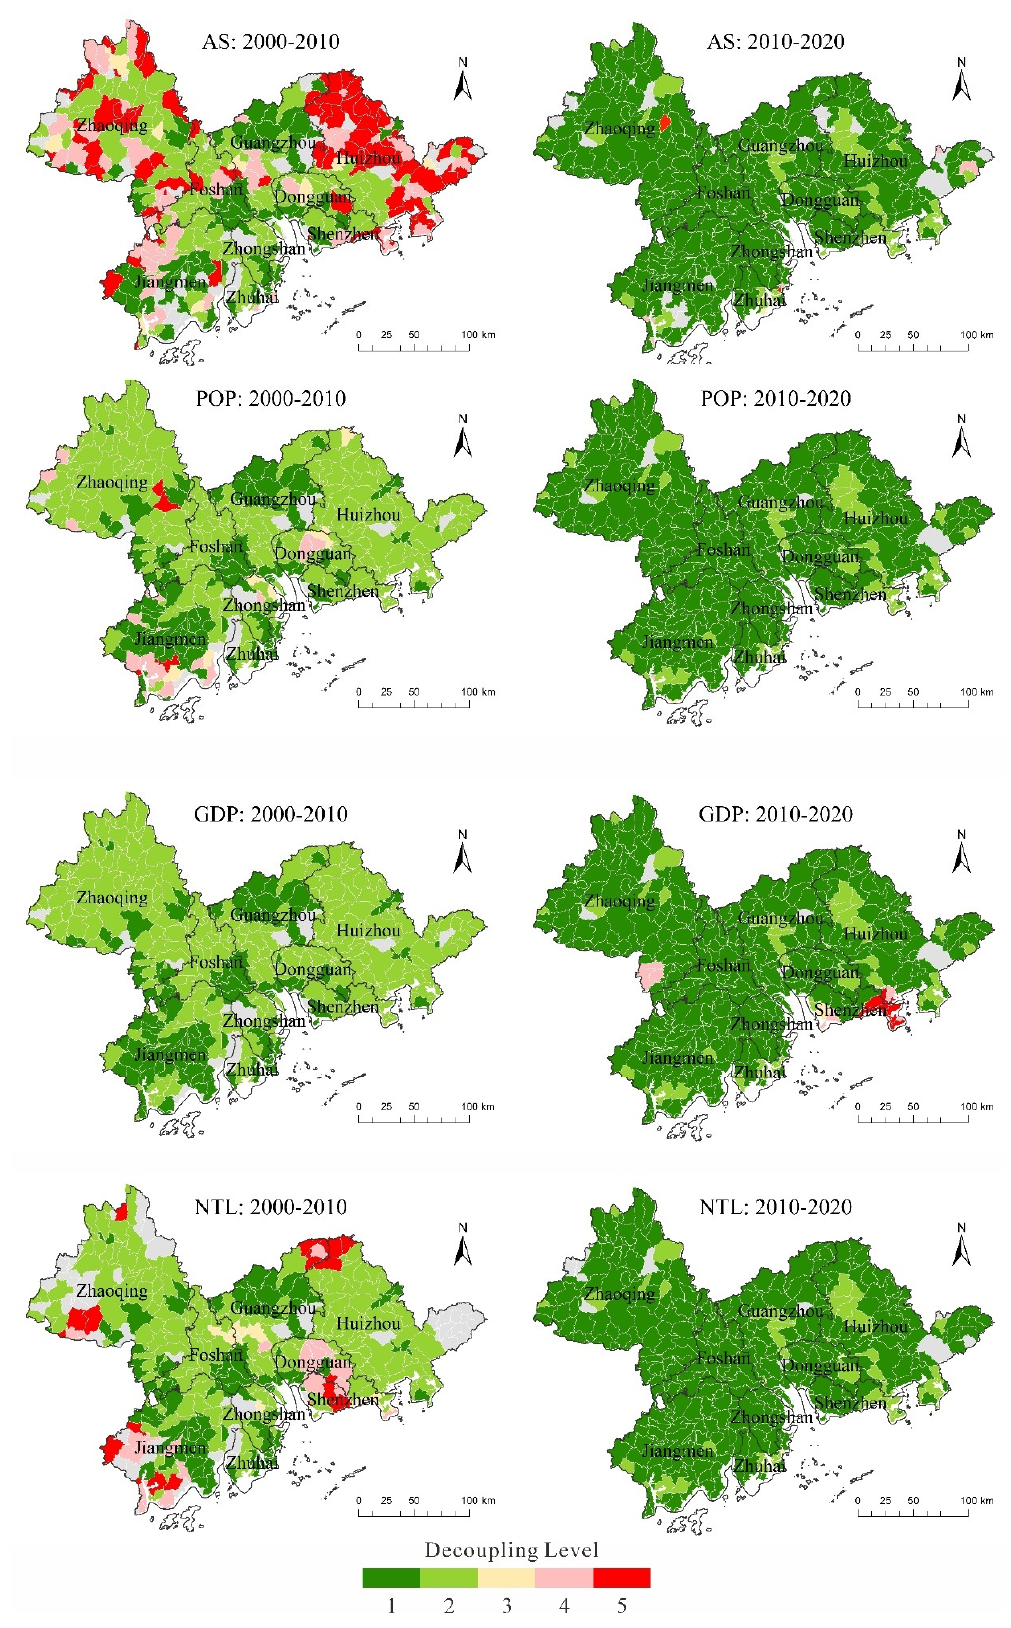
Figure 12. Decoupling level between socioeconomic factors and net primary productivity (NPP) before and after 2010.